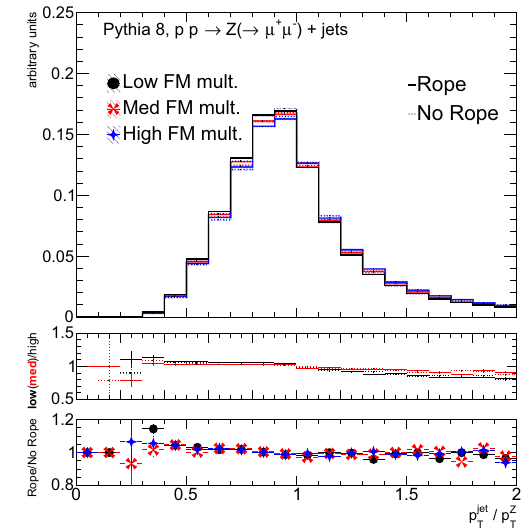
Fig. 10 The distribution of the ratio x ZJ = p T , J / p T , Z for three bins of the TTM (top left), ZTM (top right), or FM (bottom) multiplicity: the 50th, 75th, and 90th percentile. The middle panel shows the ratio of the distribution for high to low multiplicity for both hadronization models (standard hadronization with a dotted line). In the lower panel, the ratio between the Rope and standard hadronization models is displayed for all three multiplicity regions. The corresponding plots for TTM and ZTM are in the appendix, Fig. 19